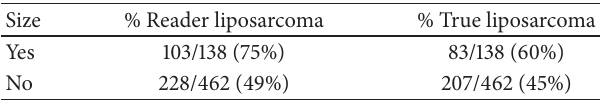
Table 3: The relationship of concerning size to the diagnosis of